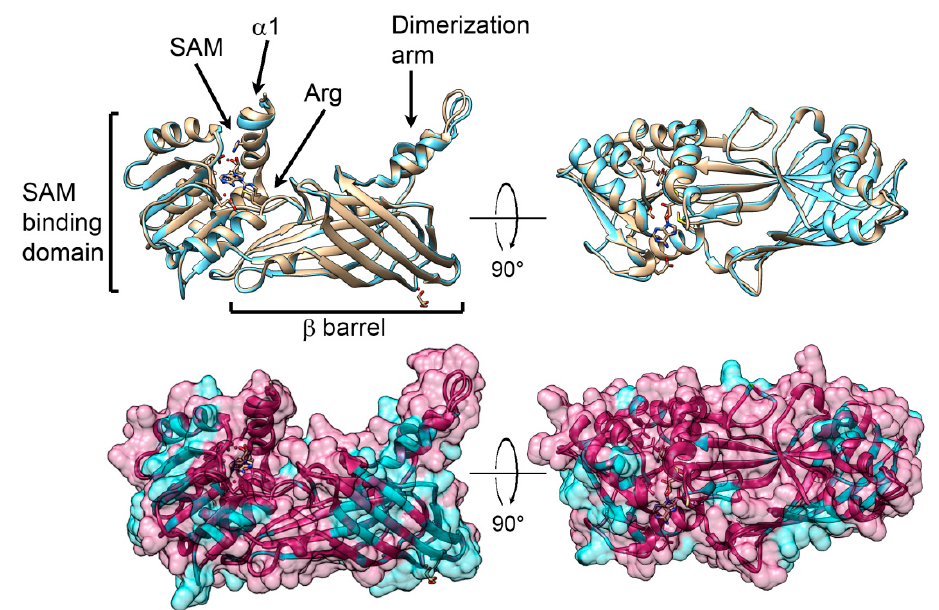
Figure 8. Molecular evolution of sea urchin PRMT1. Top: Superposition of three-dimensional models in ribbon representation of rat PRMT1 (1ORH; showed in pale) and P. lividus PRMT1 showed in light blue. Bottom: same superposition in surface (50% transparency) representation with their structures coloured according to the evolutionary conservation of amino acids. The P. lividus 3D structure was created via the Phyre 2 software [87] and rendered by using Chimera package [88]. Variable positions are presented in blue; while conserved amino acids are shown in red as defined in the colour-coding bar. In all the structures only the residues after amino acid 40 are shown, since the amino terminus is disordered.